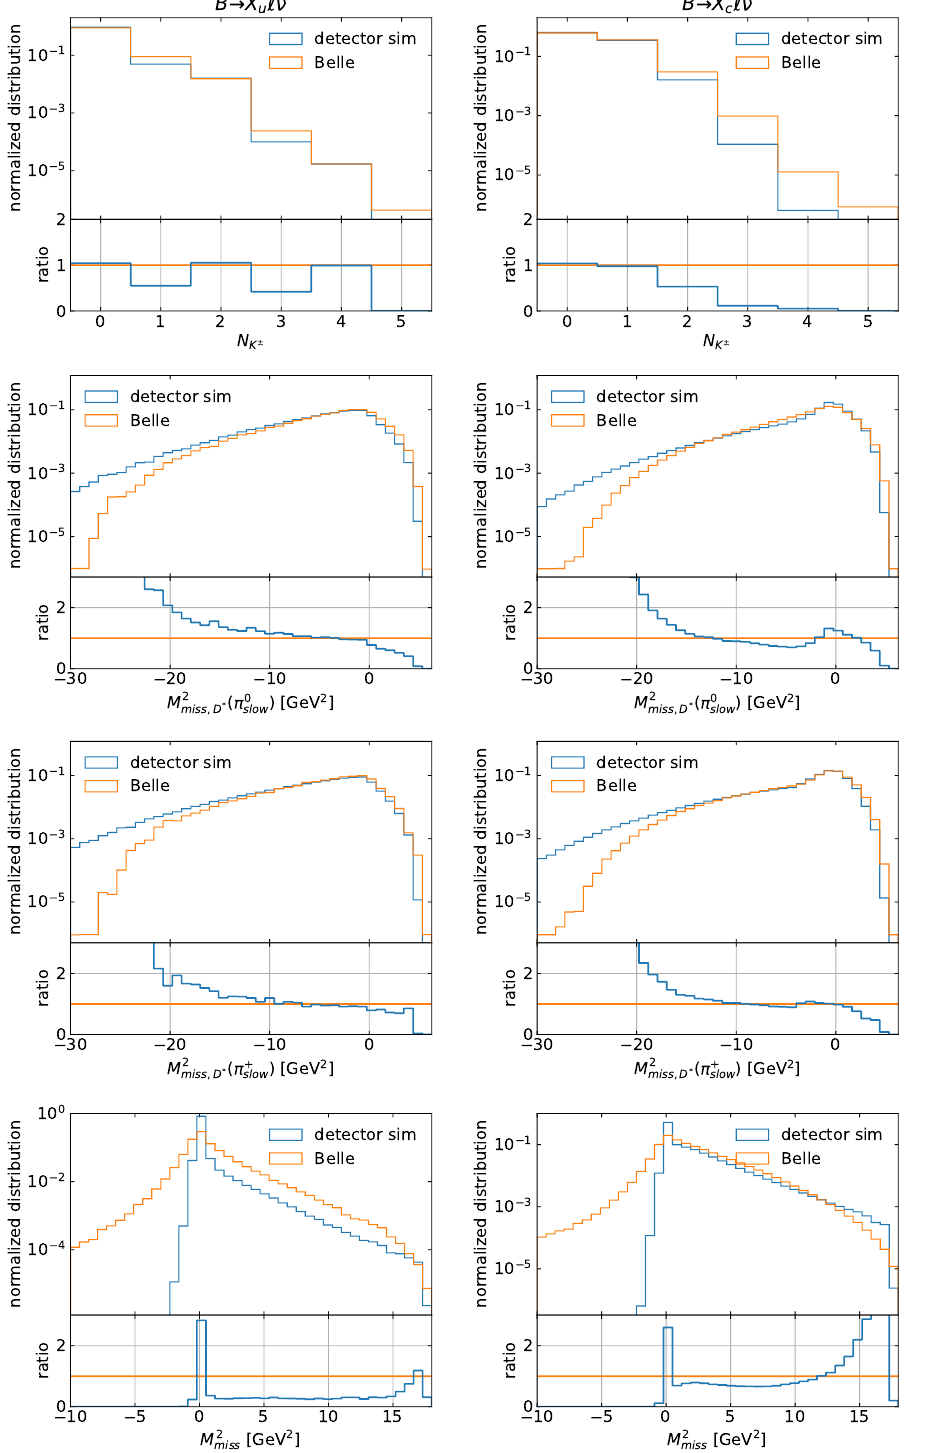
Figure 10 . Detector simulation validation plots for signal (left) and background (right) contributions. We compare the distributions of our MC events after detector simulation (detector sim) with the MC events produced by the Belle collaboration displayed in figure 14 of ref. [7]. See paragraph below eq. (3.2) for the feature